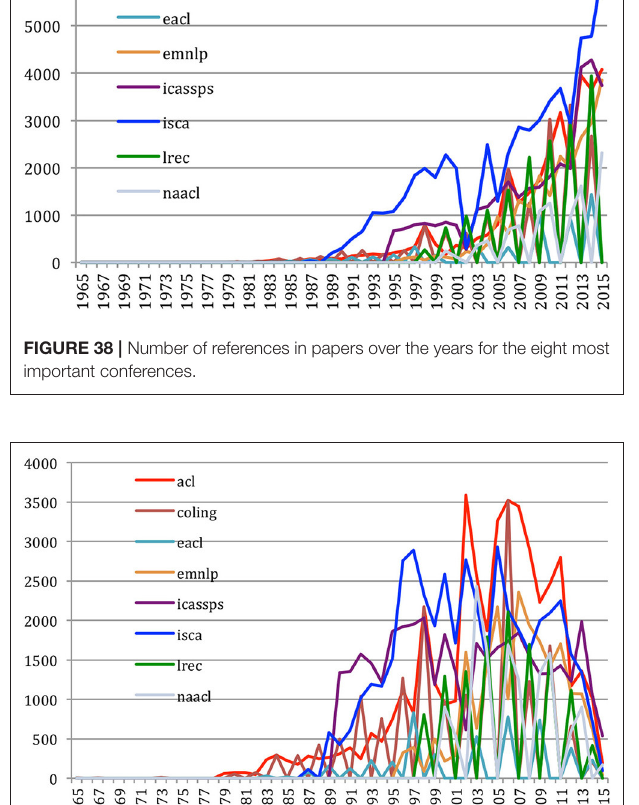
to the given year. In this case, we see ( Figure 40 ) that the number of ISCA papers being cited grows at a high rate over time. The same appears for ACL with some delay, which is now caught up.